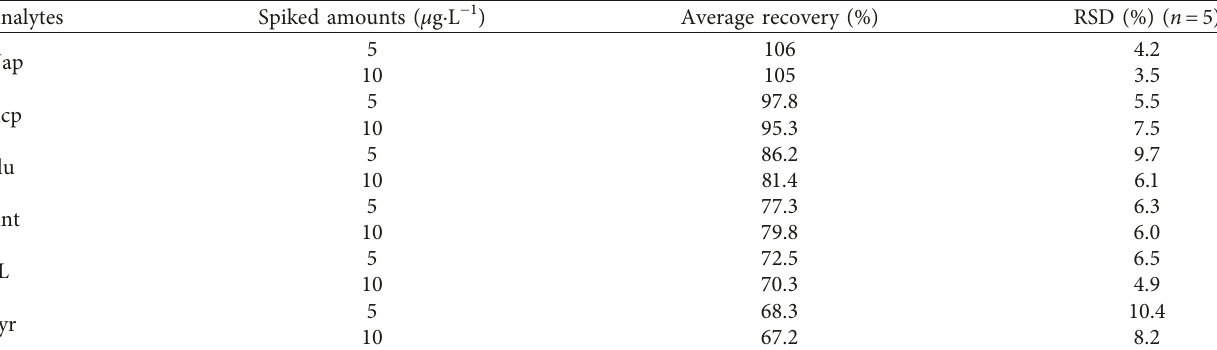
Figure 7: Chromatograms of (a) standard solution (200 µ g · L − 1 ), (b) ionic liquid extracted spiked seawater (10 µ g · L − 1 ), and (c) ionic liquid- extracted blank seawater. Peaks: (1) naphthalene; (2) acenaphthene; (3) fluorene; (4) anthracene; (5) fluoranthene; (6) pyrene. Table 4: Spiked recoveries of the six PAHs in real seawater